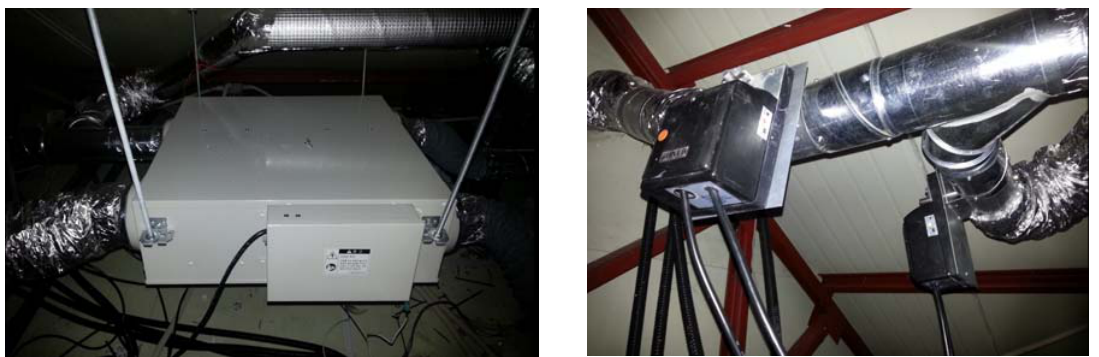
Figure 6. Air ‐ to ‐ air heat exchanger and duct controller of the HRV system installed in the experimental house.